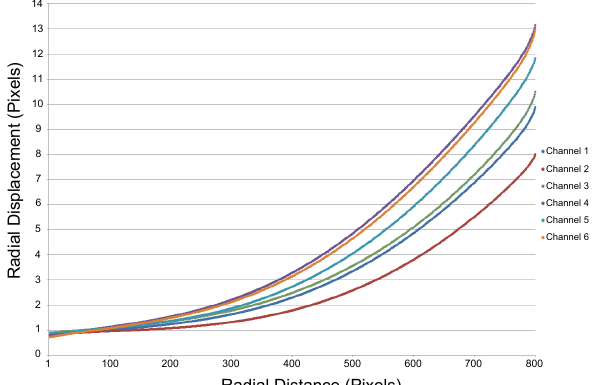
Figure 8: Rate of Lens Distortion Radial Shift